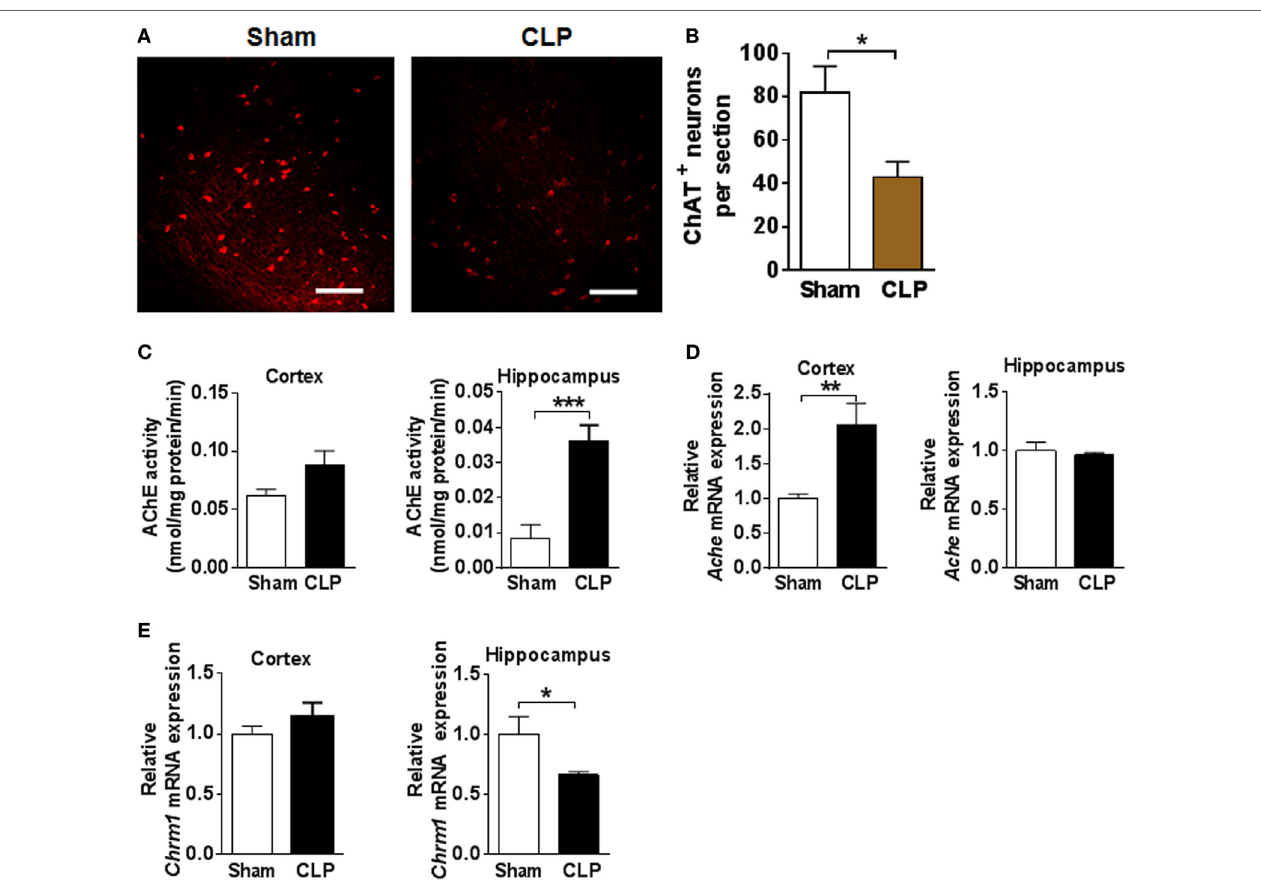
FigUre 4 | Cecal ligation and puncture (CLP) has a significant impact on basal forebrain cholinergic balance in sepsis survivors. (a) Representative images of choline acetyltransferase (ChAT) immunostaining in the basal forebrain of sham and CLP mice (scale bar = 100 μ m). (B) Quantitative analysis of ChAT immunostaining in the basal forebrain of sham and CLP mice. * P = 0.0229, Student’s t -test, n = 5 per group. (c) Acetylcholinesterase (AChE) activity in cortex and hippocampus of sham and CLP mice. *** P = 0.0004, Student’s t -test, n = 8 per group. (D) Relative Ache mRNA expression in cortex and hippocampus of sham and CLP mice. ** P = 0.0052, Student’s t -test, n = 8 per group. (e) Relative Chrm1 mRNA expression in cortex and hippocampus of sham and CLP mice. * P = 0.0481, Student’s t -test, n = 8 per